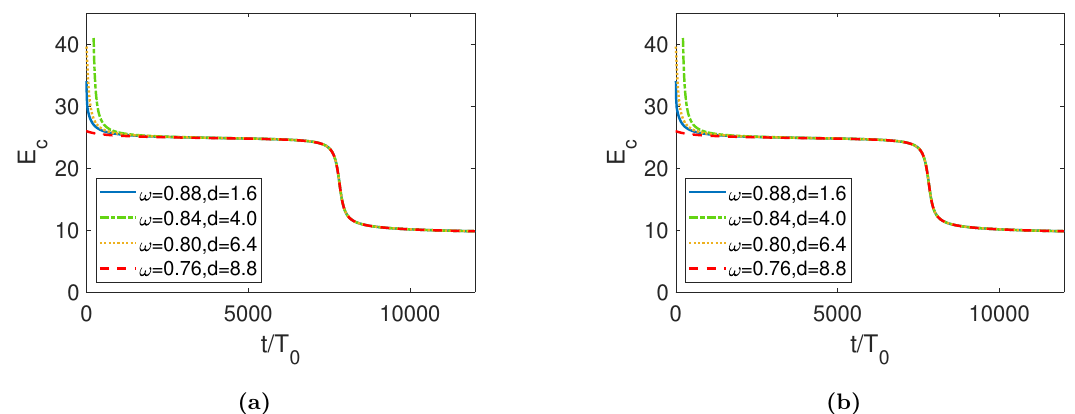
Figure 20. Attractor behaviors of the dipole CSQ in the E c and envelope of Q s plot. The initial configurations are constructed by superimposing elementary Q-balls.